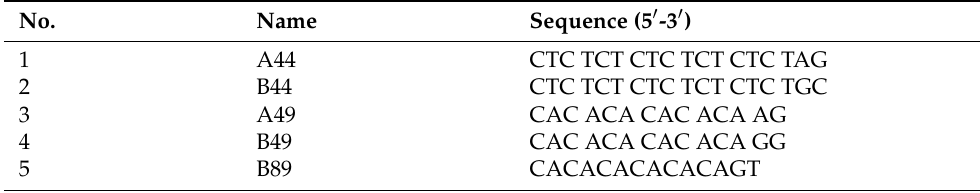
Table 2. List of ISSR primers used in rice genotyping.